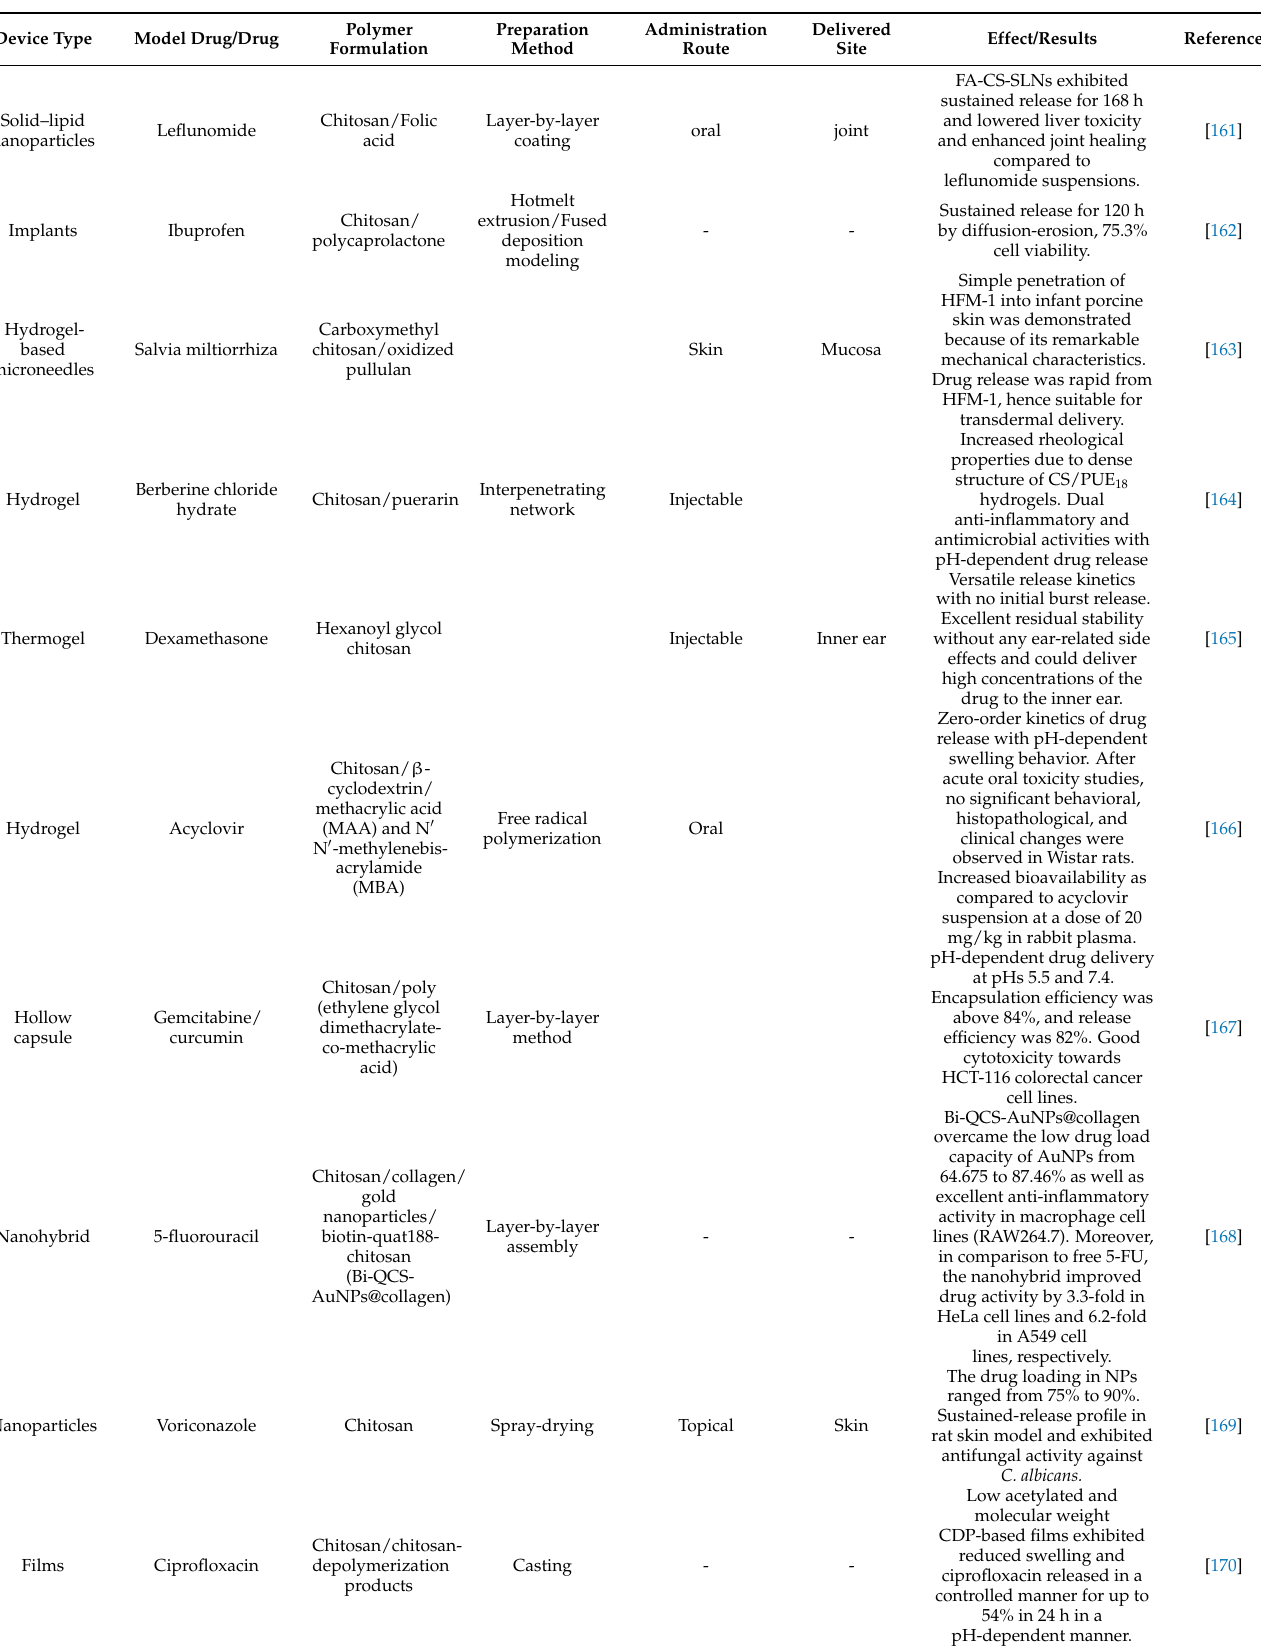
Table 1. Recent studies on chitosan focusing on delivering therapeutic